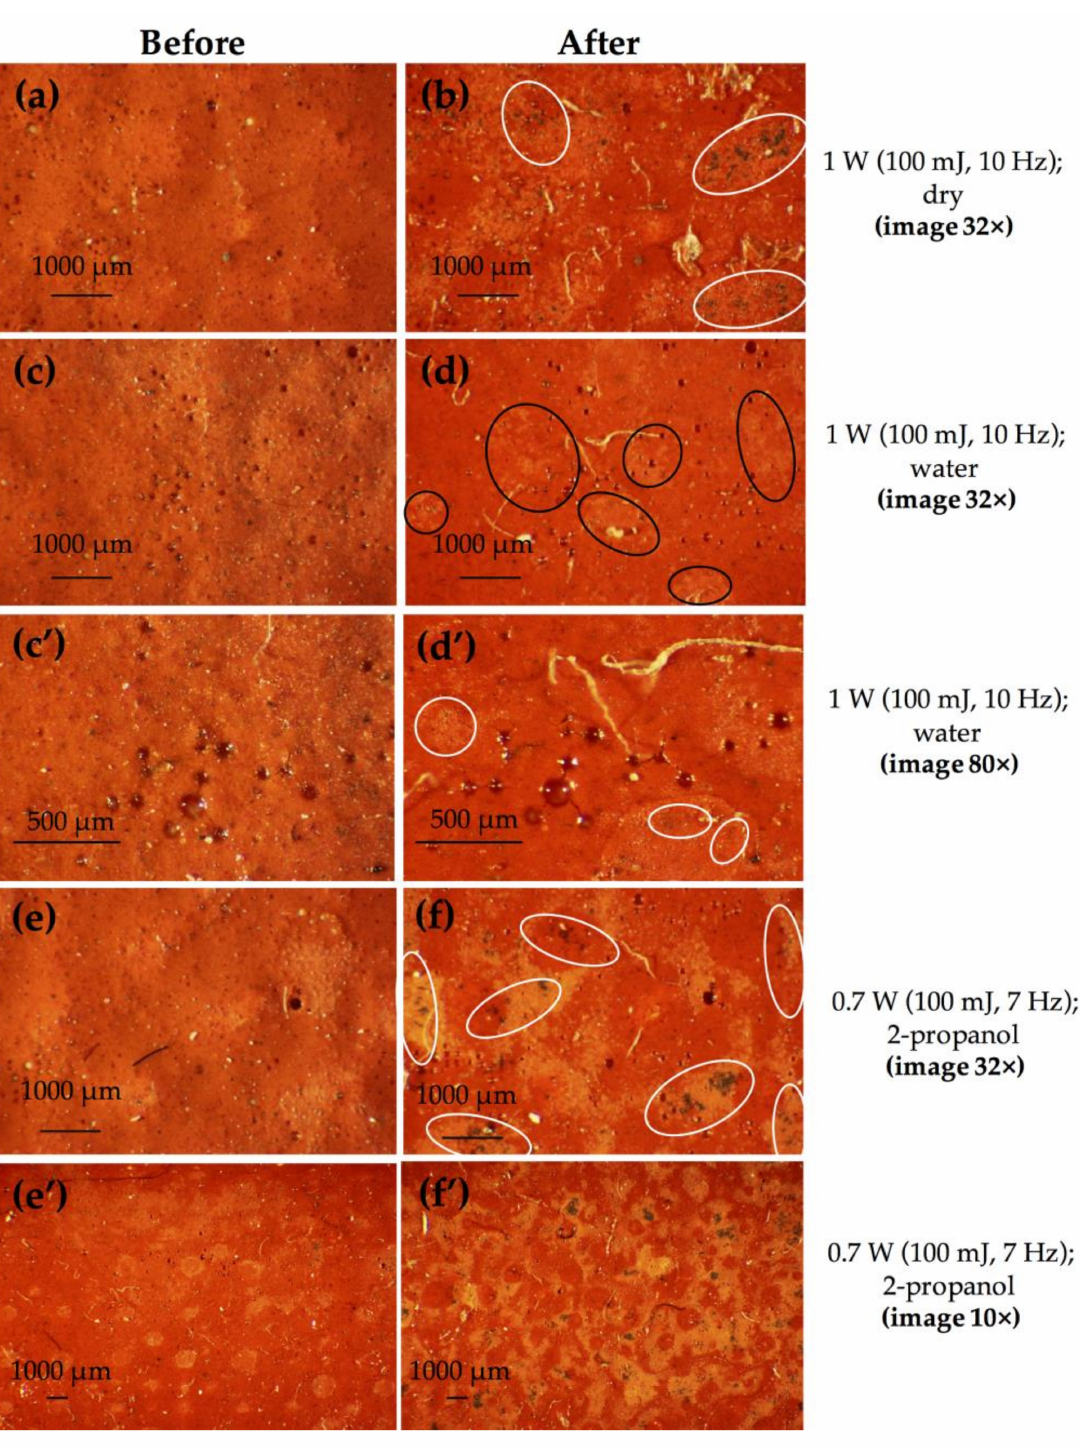
Figure 2. The microscopic images (10 × , 32 × and 80 × ) of mastic removal by Er:YAG laser under varied conditions and parameters, conducted on cinnabar tempera mock-ups. ( a , b ) is image obtained before and after cleaning in dry condition, while ( c , d ) was obtained before and after cleaning in wet (H 2 O) condition. ( c (cid:48) , d (cid:48) ) (80 × ) was zoomed images of ( c , d ) at the same location, and ( e (cid:48) , f (cid:48) ) was taken at the same location as ( e , f ) but with 10 × of